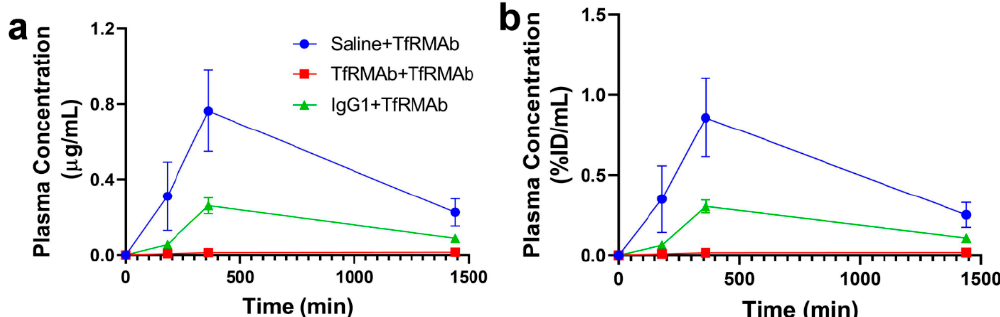
Figure 8. Plasma concentration-time profiles of the high-affinity bivalent TfRMAb following chronic dosing in mice. Mice were treated with a single 3 mg/kg TfRMAb SQ injection one week after chronic four-week treatment with saline, TfRMAb or IgG1 ( n = 4 per group), and plasma samples were collected at 3 (180 min), 6 (360 min) and 24 (1440 min) hours after injection. Plasma TfRMAb concentrations are shown as either µg/mL ( a ) or %ID/mL ( b ). Data is shown as the mean ± SEM. Table 2. PK parameters of TfRMAb following a single 3 mg/kg SQ injection in mice following four-week chronic dosing of saline, TfRMAb or IgG1. Data is shown as the mean ± SEM of n = 4 per group. Treatment